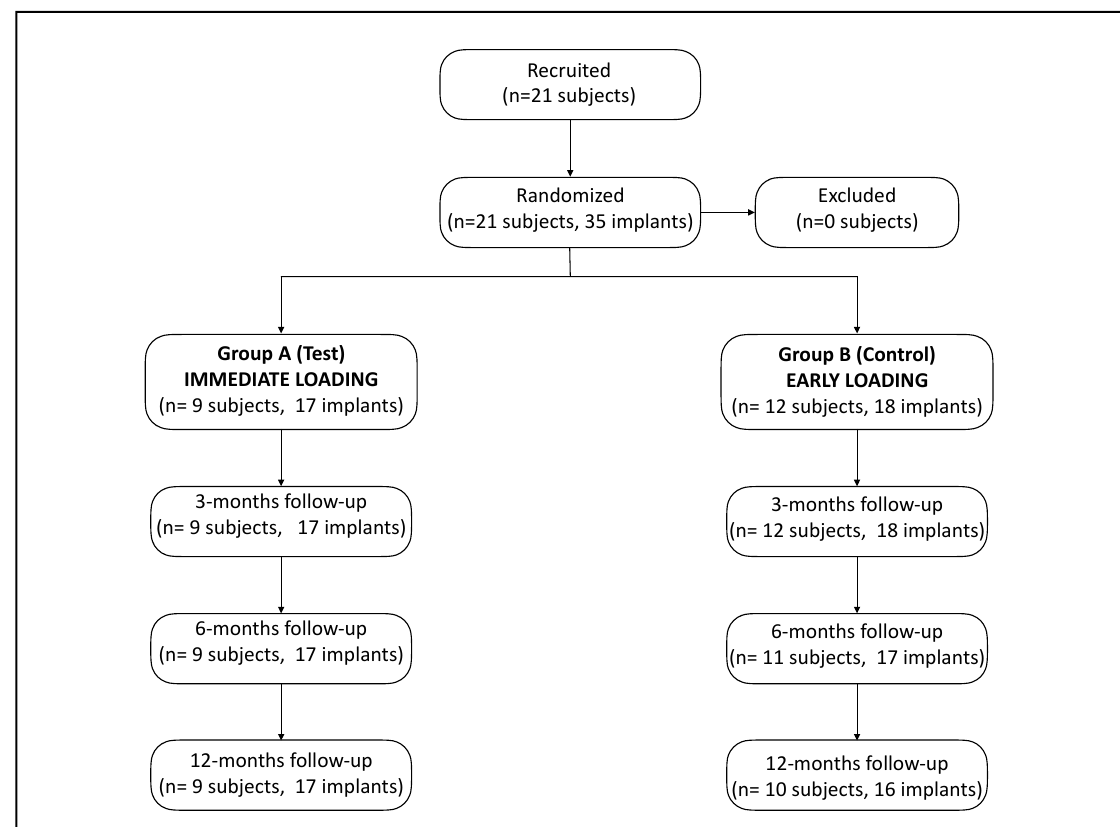
Figure 2. Study sample flow-chart.